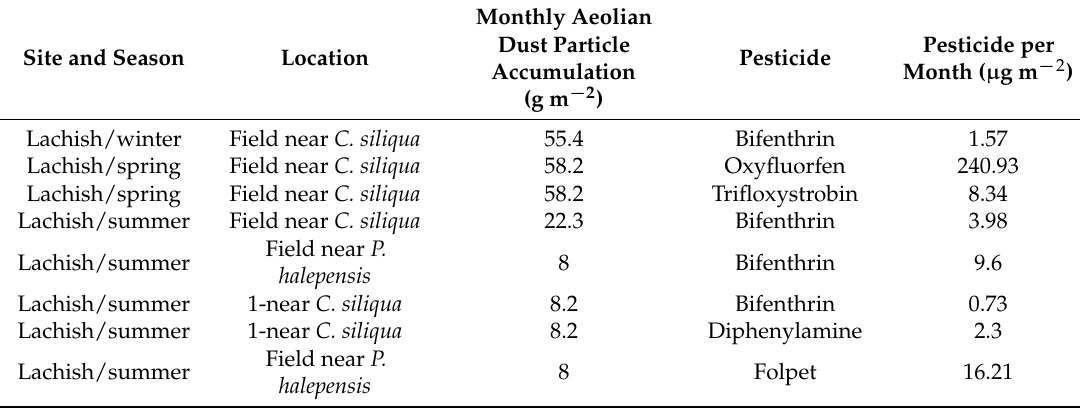
Table 4. Types of pesticides that were found at Lachish between December 2014 and August 2015. Center of cultivated field [Field]; Beneath the first row of the tree belt (1). Data are monthly averages for the seasons: winter (December 2014–February 2015); spring (March–May 2015) and summer (June–August 2015). No pesticides were found at Asaf during this period. The table presents only the periods during which pesticides were